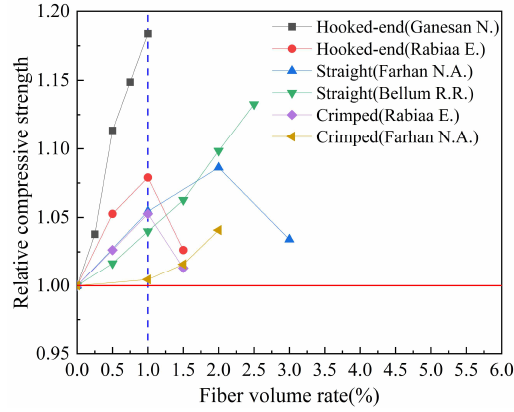
Figure 12. The effect of fiber shape on compressive